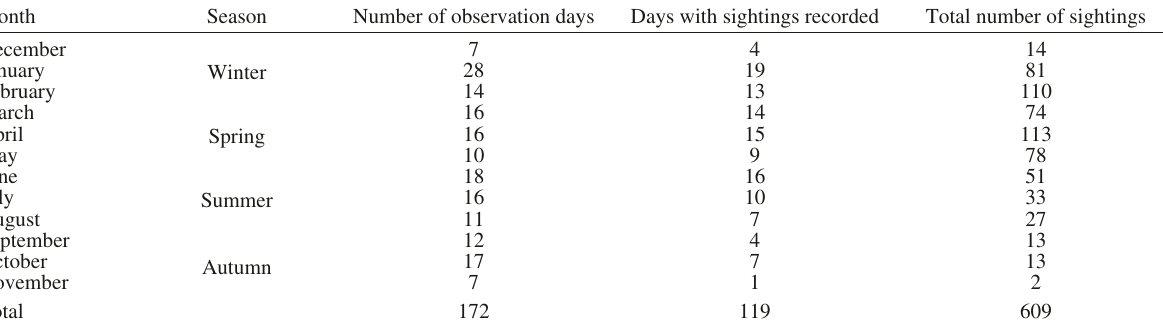
Table 1. – Number of observations and animal sightings during the fieldwork conducted between January 2018 and May 2020.